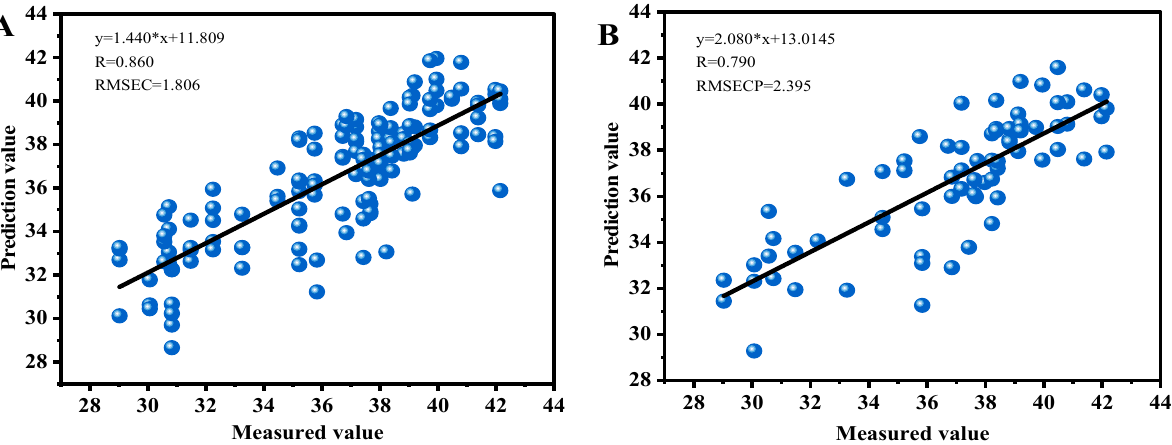
Figure 5. PLSR combined with S-G preprocessing modeling. ( A ) shows the effect of PLSR combined with S-G preprocessing for the calibration set, and ( B ) shows the effect of PLSR combined with S-G preprocessing for the prediction